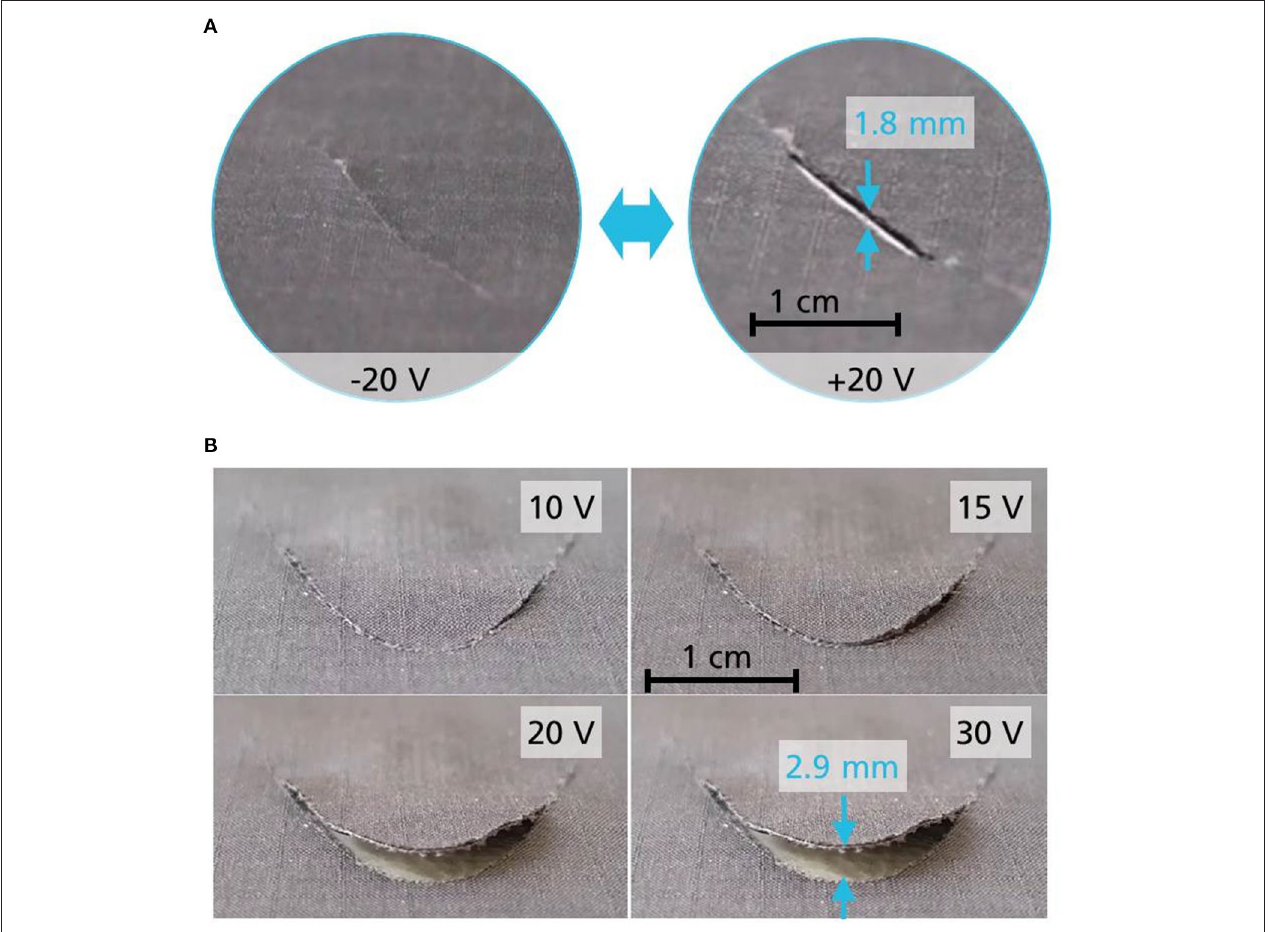
FIGURE 12 | Examples of successfully controlled membrane apertures in (A) the double-curved slit cut demonstrator and (B) the planar flap cut